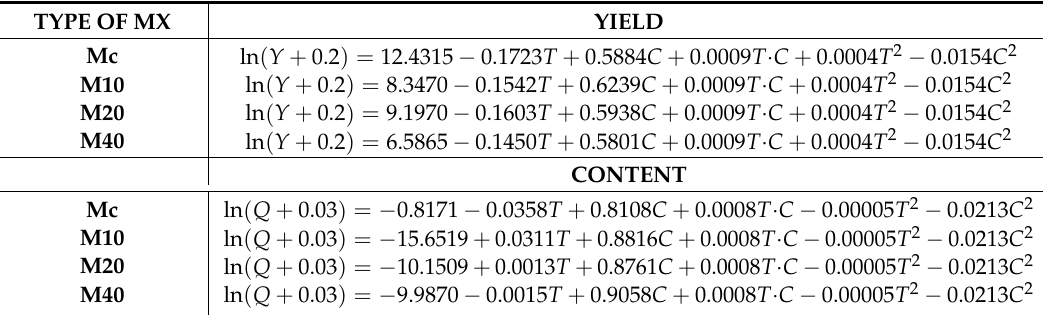
Table 3. Predicting equations extrapolated from the SRP for the yield and content of antioxidant in the BJ-MX, as a function of the type of